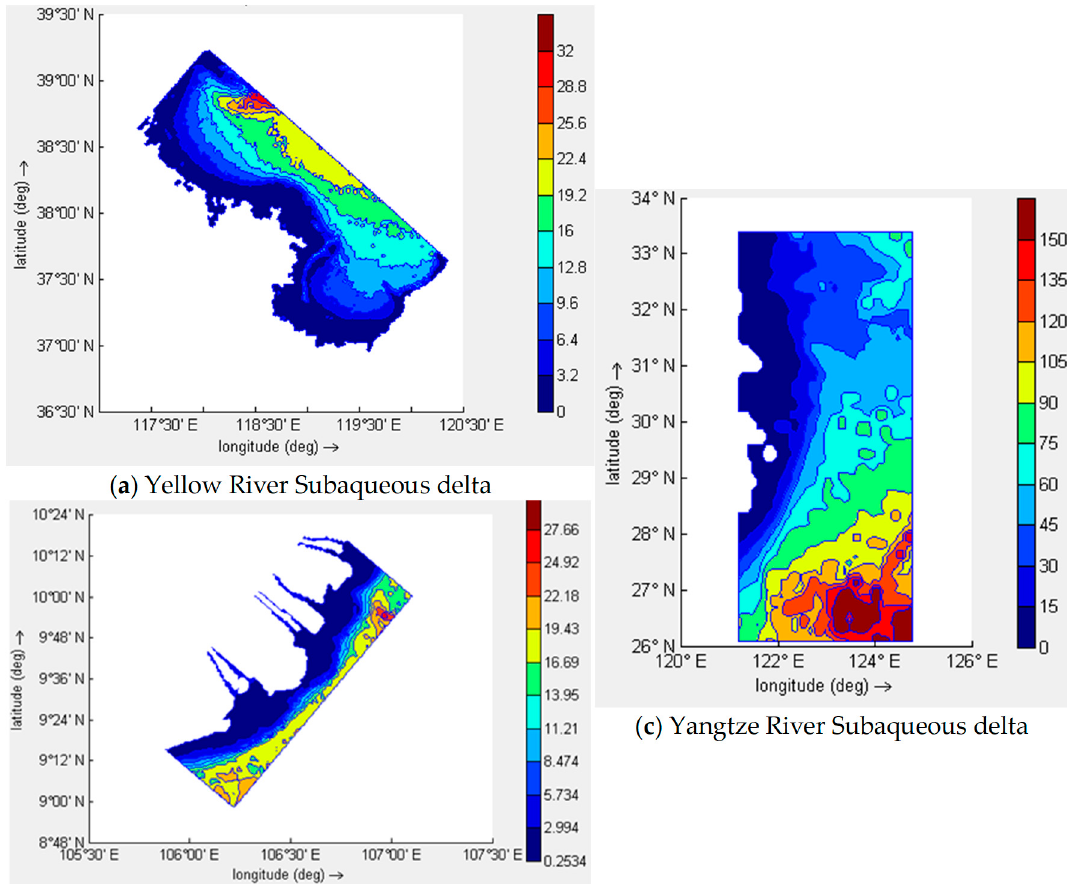
Figure 6. Water depth in Yellow River ( a ) Mekong River ( b ) and Yangtze River ( c ) Subaqueous delta (Unit: m).